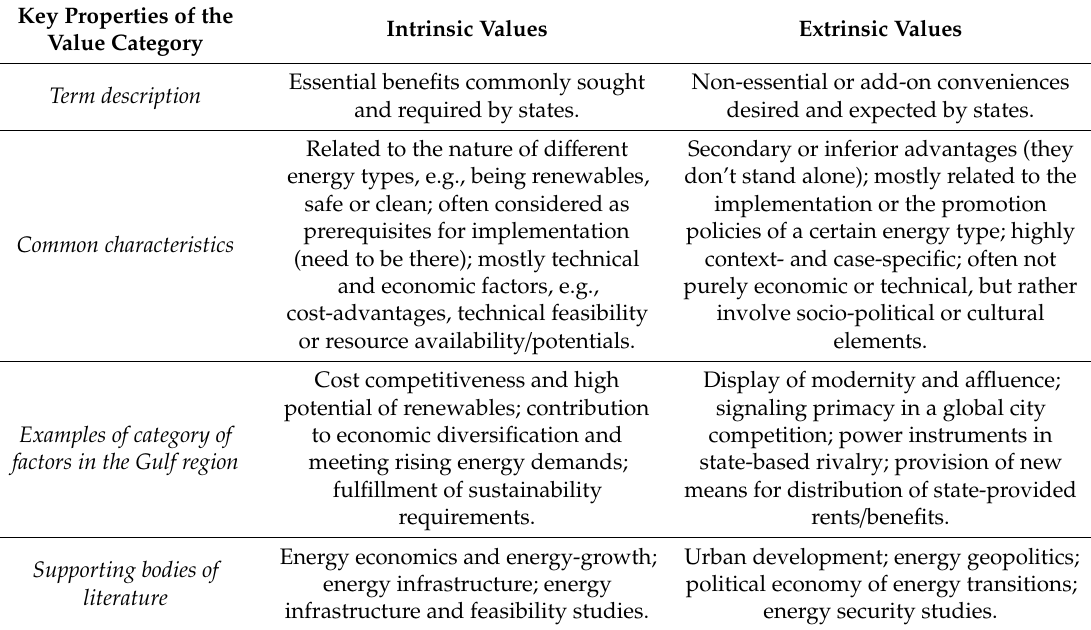
Table 1. Overview of key terms and